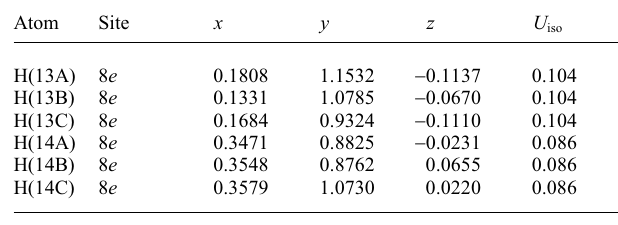
Table 3. Atomic coordinates and displacement parameters (in Å 2 )